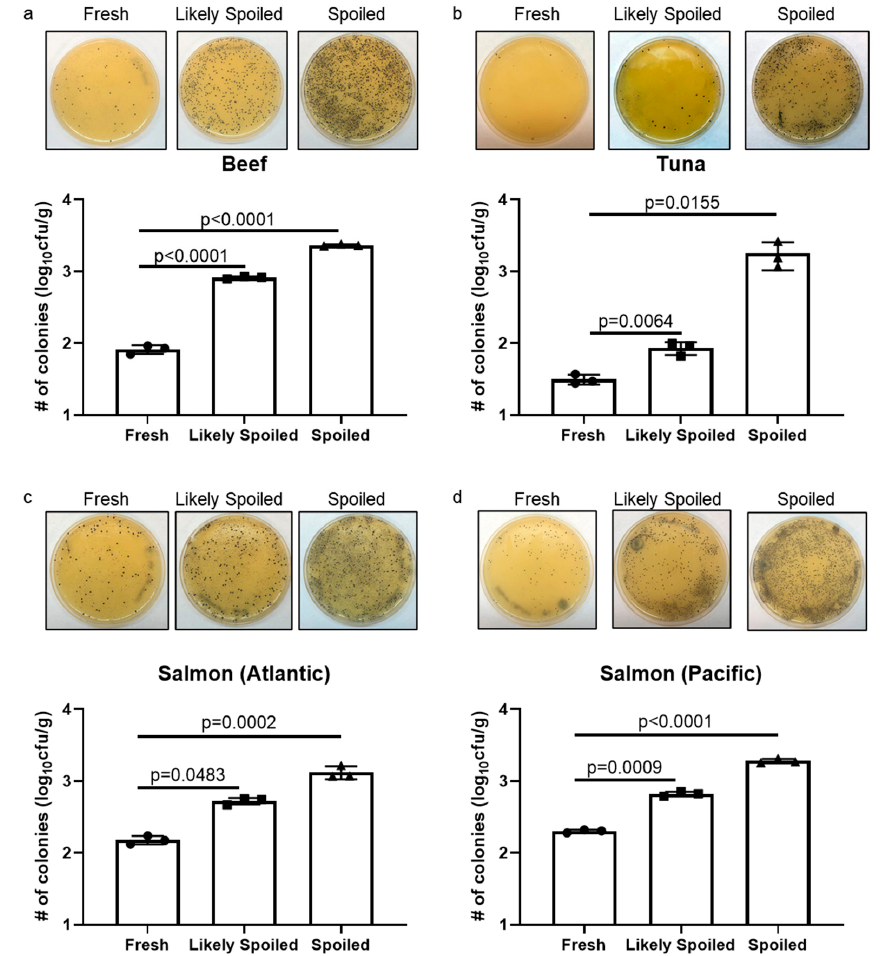
Figure 3. Growth of Streptococcus Aureus as an indicator of food freshness.